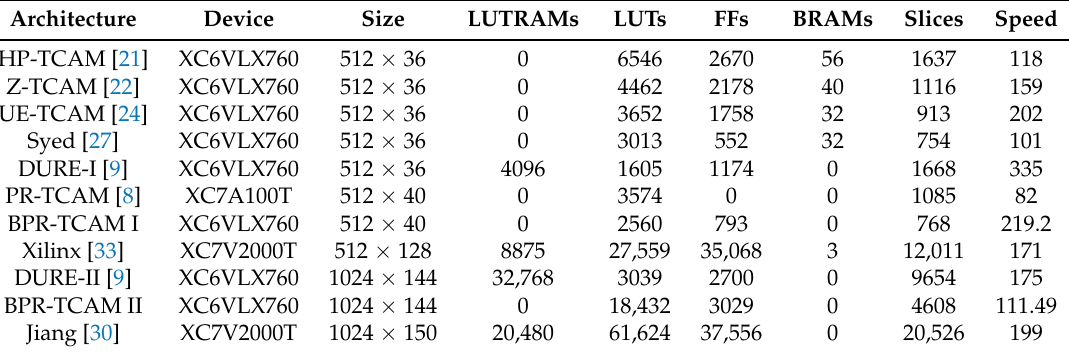
Table 2. Resource and Speed (MHz) comparison of BPR-TCAM with state-of-the-art TCAMs. Architecture